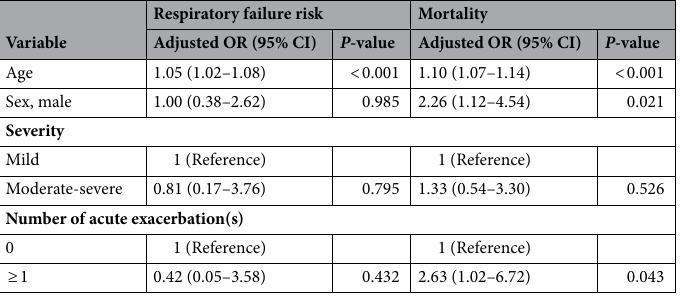
Table 4. Multivariate analyses of risk factors associated mortality in patients with asthma. OR, odds ratio; CI, confidence interval; MPR, medication possession